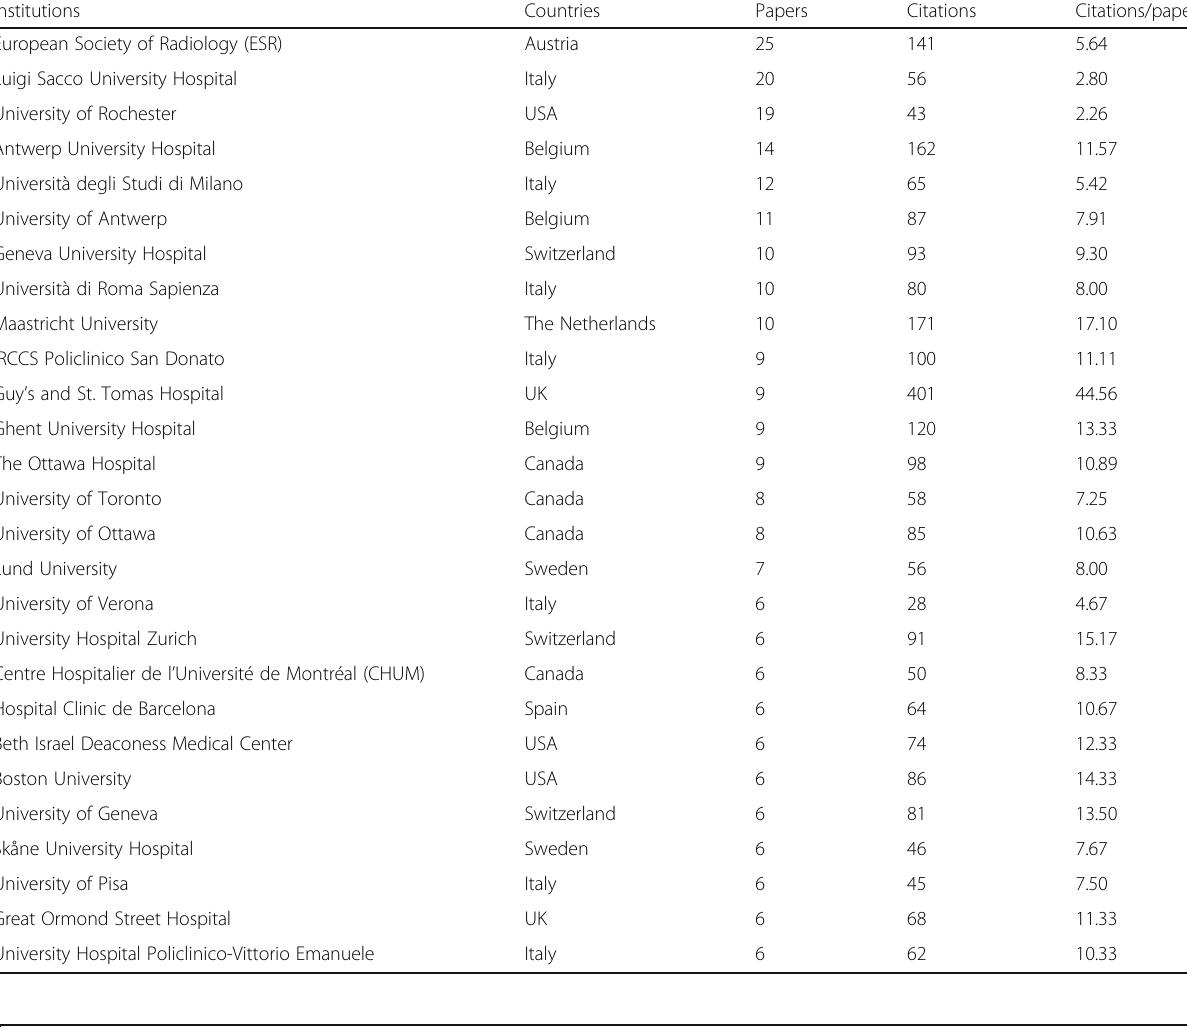
Table 2 Most productive institutions ( n > 5 published papers)